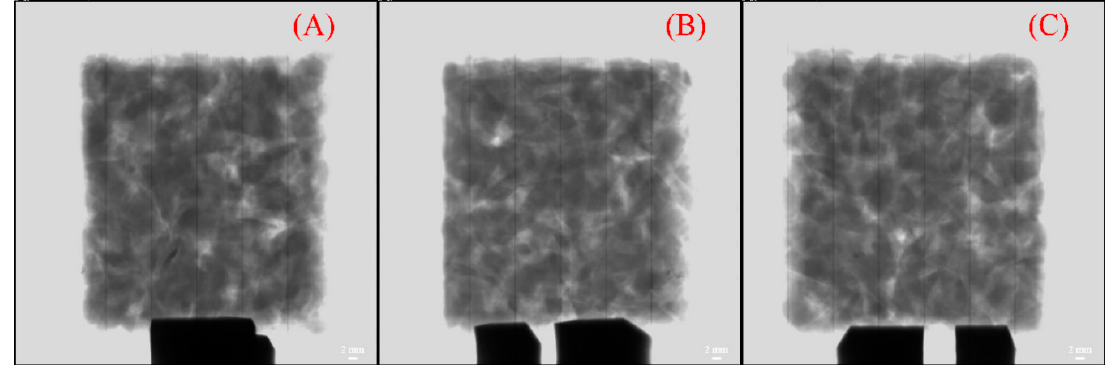
Figure 8. The CT images of cube samples with different voidage: ( A ) 4.08%, ( B ) 4.32%, ( C ) 4.56%.